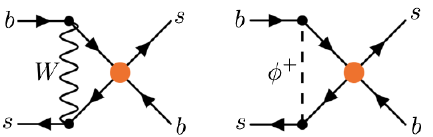
Figure 2 . Diagrams generating contributions to B s mixing from the SMEFT operators Q (1) qq and Q (3) qq .